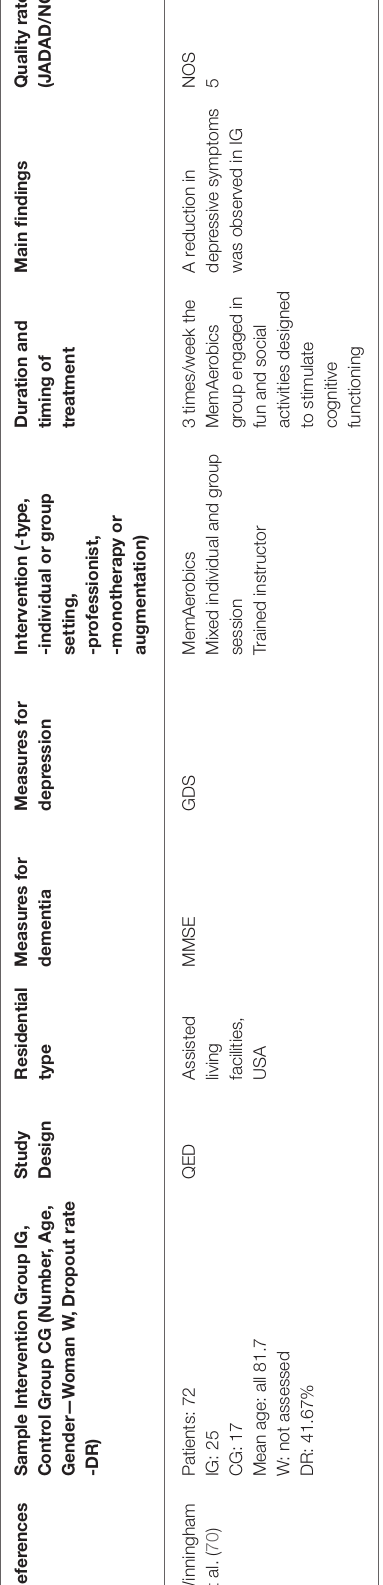
Supplementary Table 2 and Supplementary Figure 2 . Physical